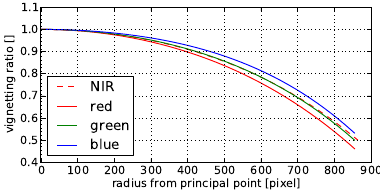
Figure 9: Fitted vignetting model of all spectral bands in one plot. As in (Edirlsinghe et al., 2001) the vignetting differs between the individual spectral bands. The peripheral brightness is reduced up to 47% and varies up to 13% between the bands.